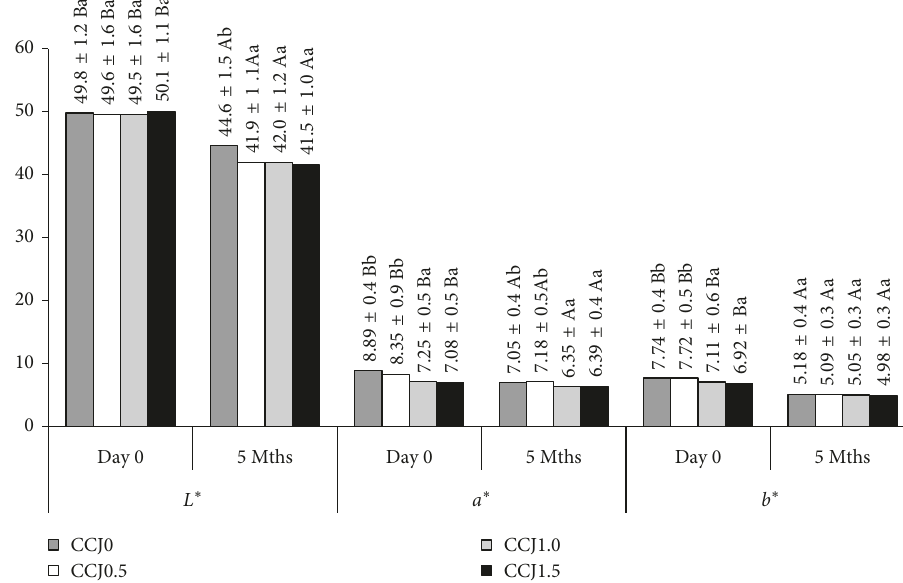
Figure 1: CIE L ∗ , a ∗ , and b ∗ color values of beef burgers, n � 6. Means followed by the different lowercase letters between the samples at the same storage time and capital letters between the same samples at different storage times indicate significant differences ( P ≤ 0 . 05) between values. L ∗ � color lightness, a ∗ � redness, and b ∗ �